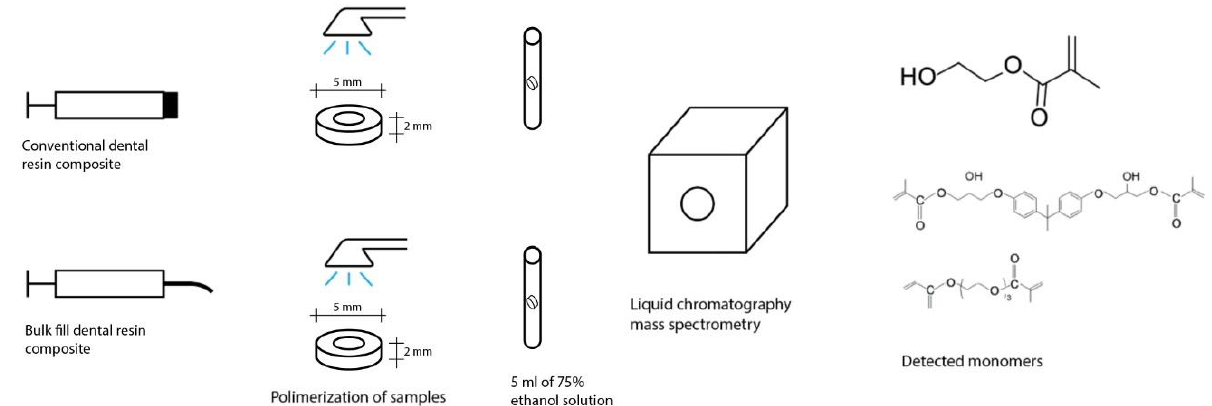
Figure 1. Sample preparation and monomer detection.